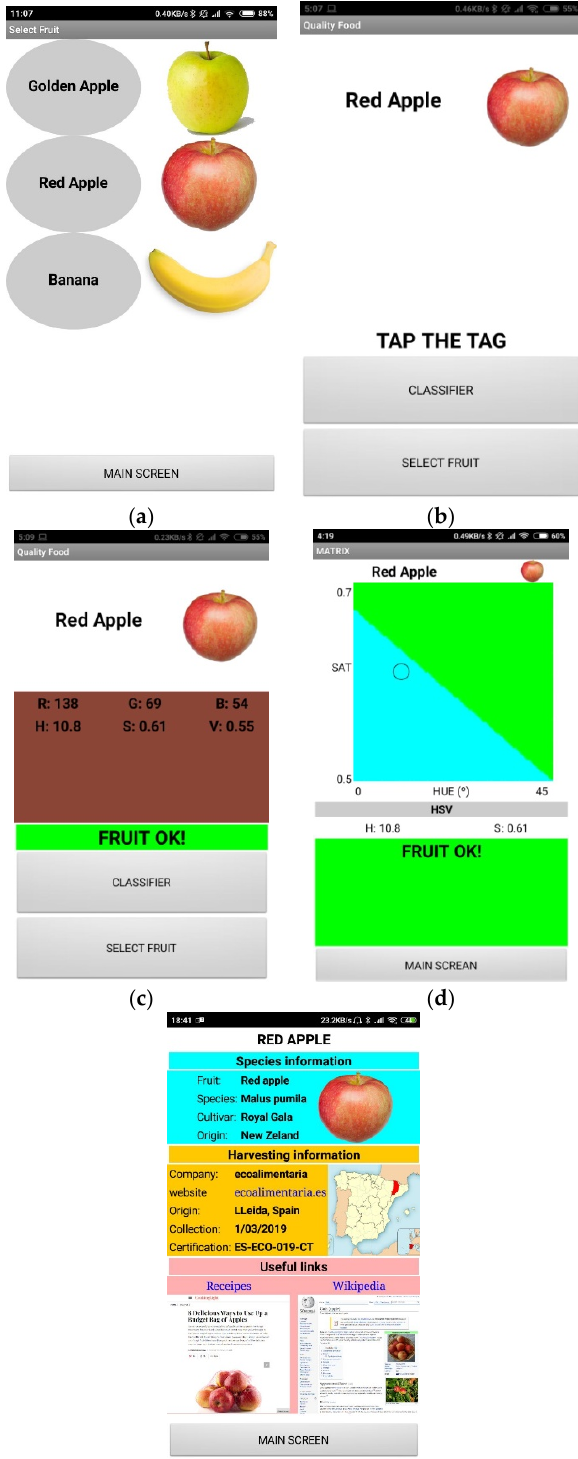
Figure 19. Phone screen of the developed application. ( a ) Fruit selection, ( b ) screen indicating to tap the tag, ( c ) representation of the detected color, ( d ) decision boundaries of the training, ( e ) additional user